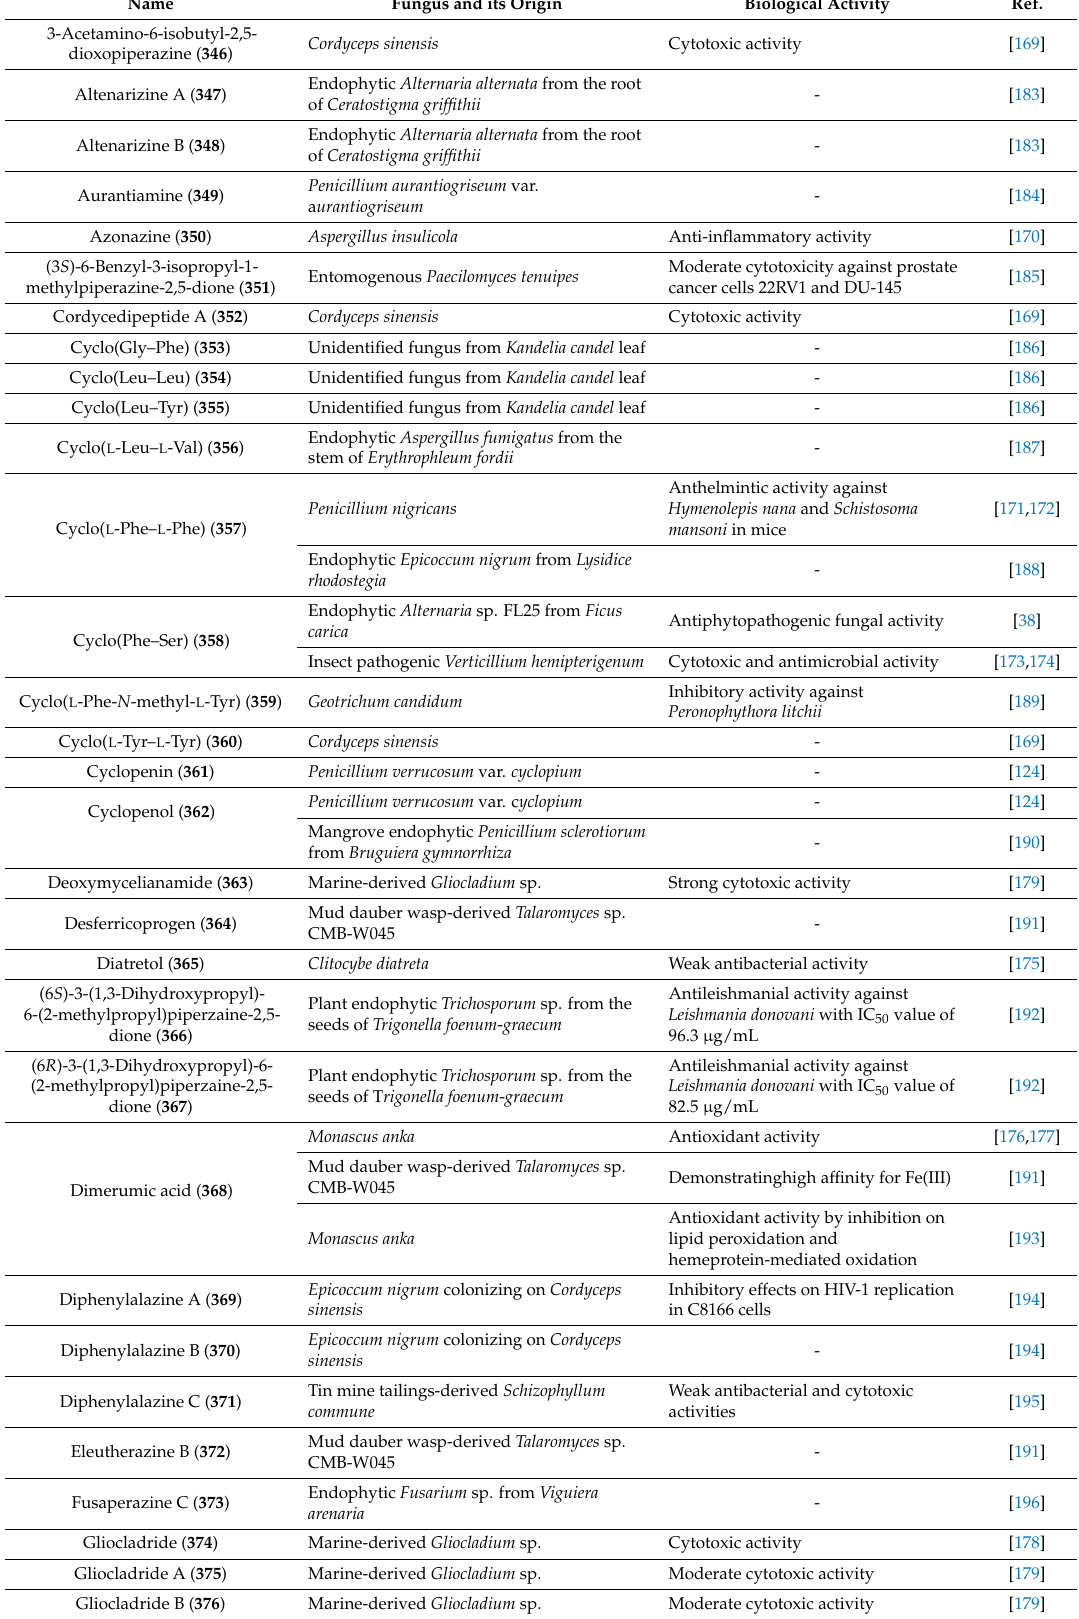
Table 5. Non-tryptophan–non-proline cyclodipeptide analogs and their biological